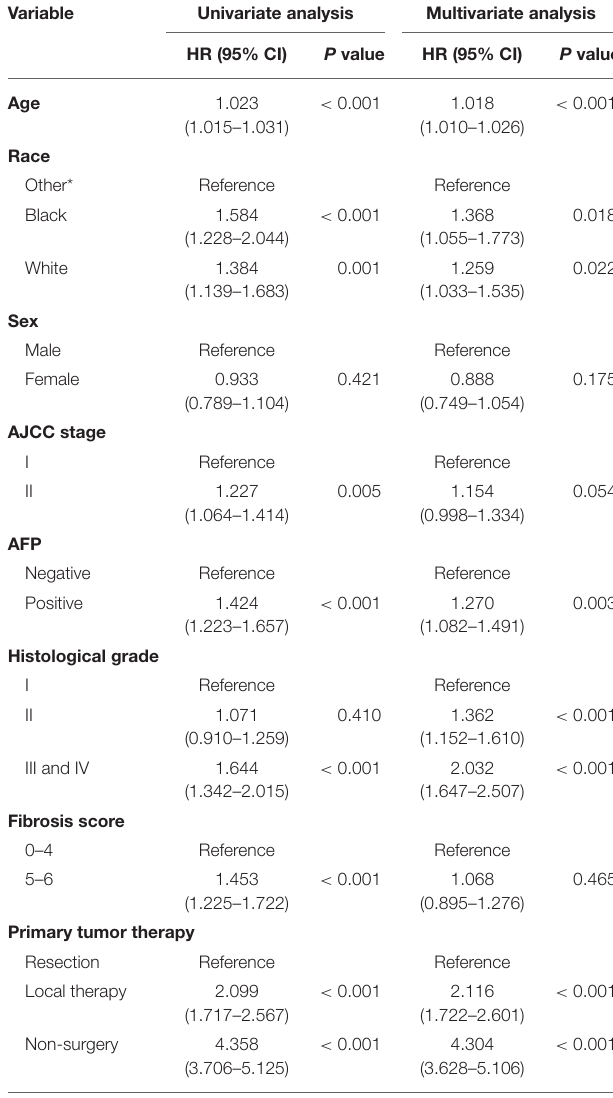
TABLE 2 | Univariate and multivariate Cox regression analyses of prognostic factors in patients with early HCC. Variable Univariate